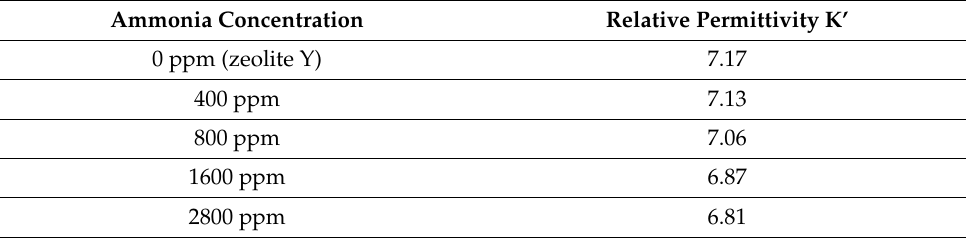
Table A4. Relative permittivity K’ of zeolite Y at different